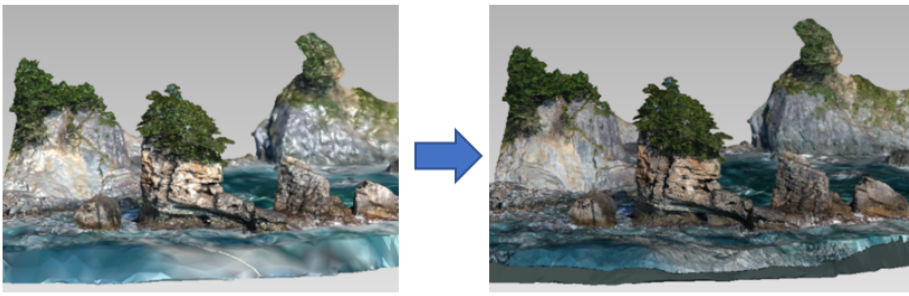
Figure 13. High-definition texturing of the rocks.